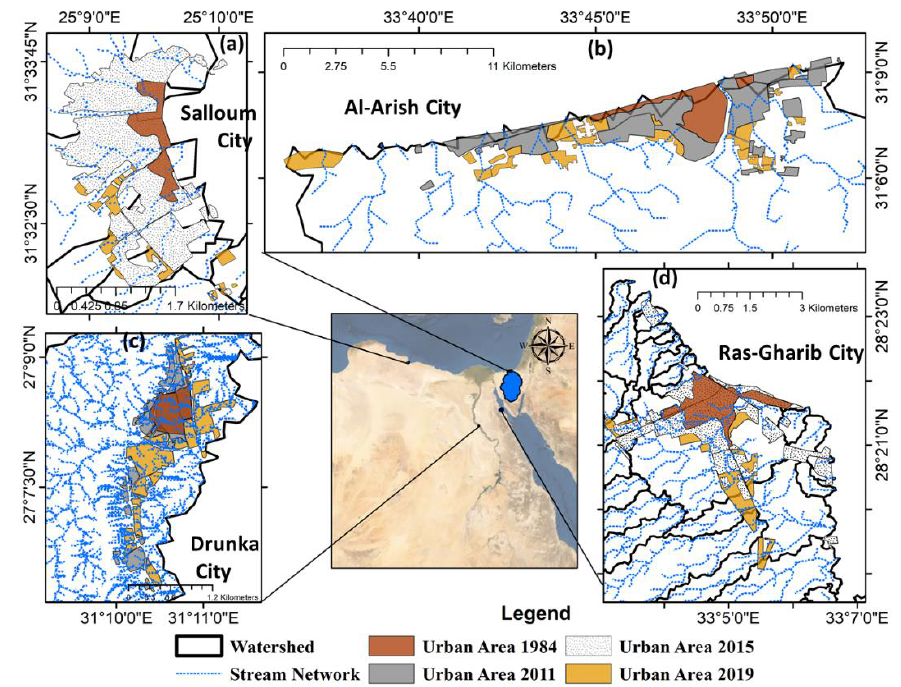
Figure 10. Spatial maps of urbanization extension at four cities at di ff erent time periods from 1984 to 2019.